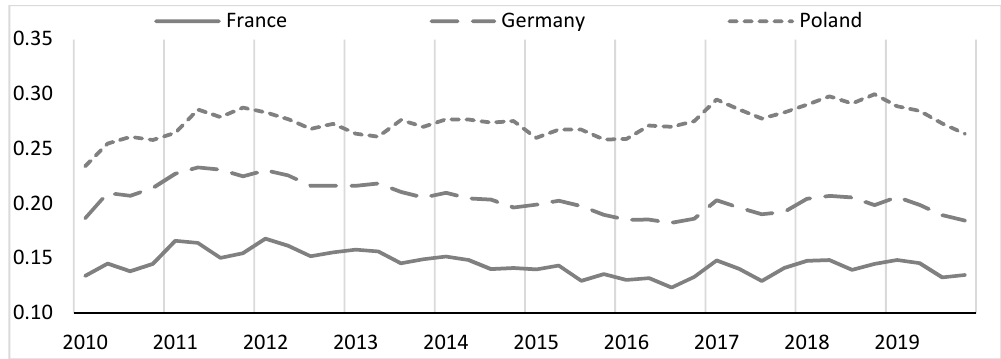
Figure 4. Import intensity of private consumption, own work, source: Eurostat.